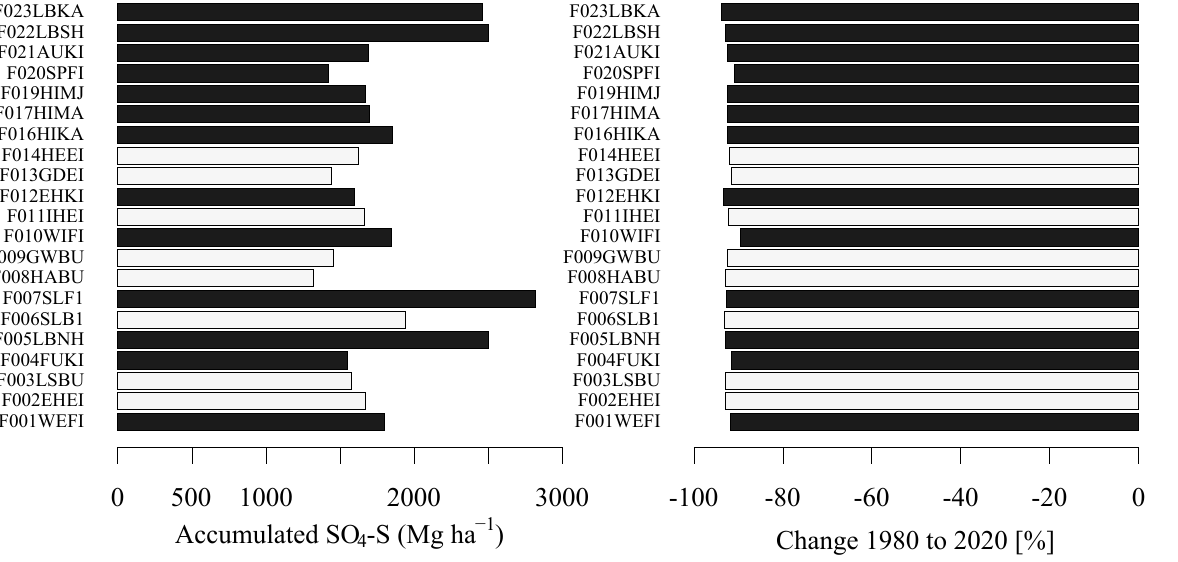
Figure 5. Estimated cumulative sulfur load ( Σ 1950 to 2020) and relative change of sulfur deposition between 1980 and 2020 for the permanent soil-monitoring plots in Lower Saxony, Germany. ■ coniferous forest; □ deciduous forest.